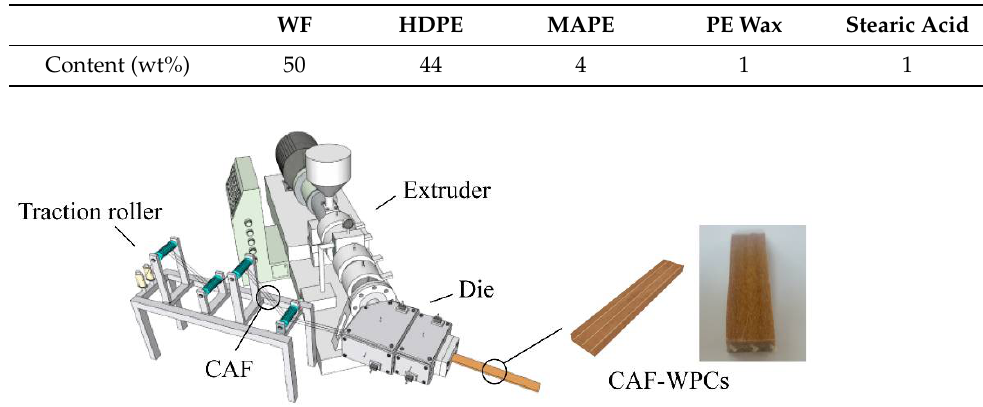
Figure 1. Schematic diagram of the processing and the shape of CAF reinforced WPCs.